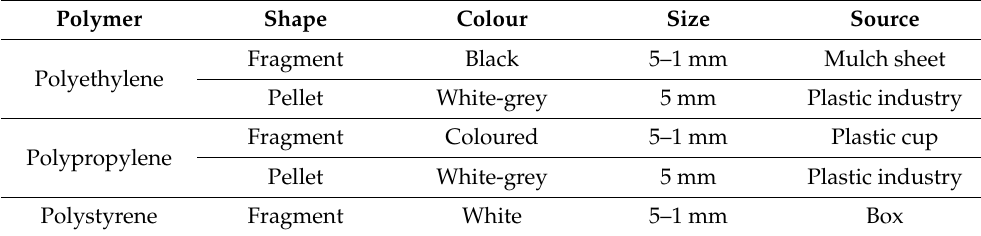
Table 1. Pristine MPs were selected for ageing under controlled